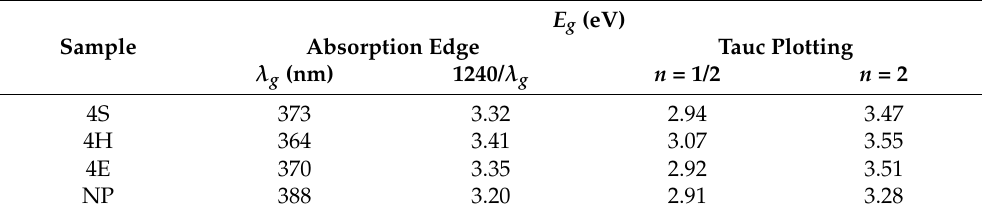
Table 1. Eg of the treated samples determined by the absorption edge method and Tauc plotting.